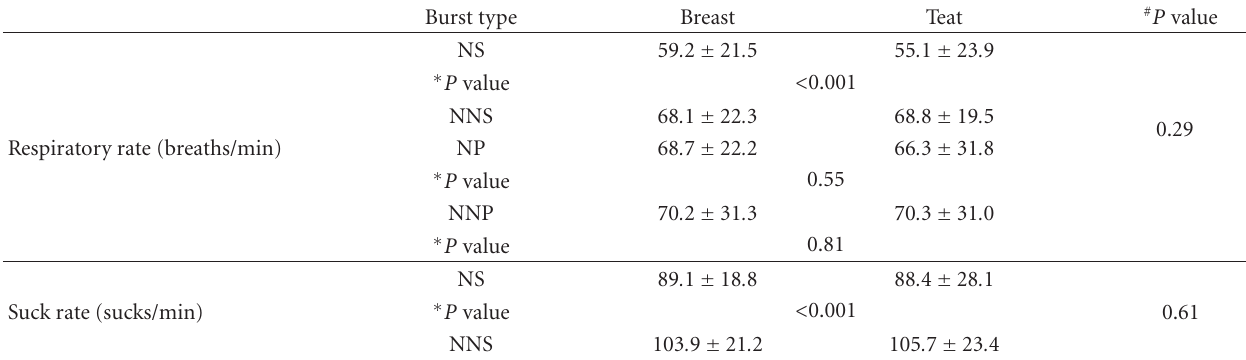
Table 5: Respiratory and sucking rate during the monitored breastfeed and the feed from the experimental teat.